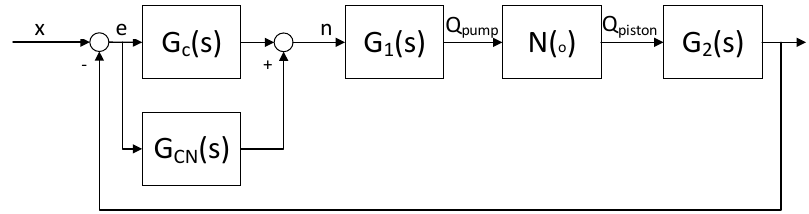
Figure 25. The transfer function diagram of the delay compensation method.